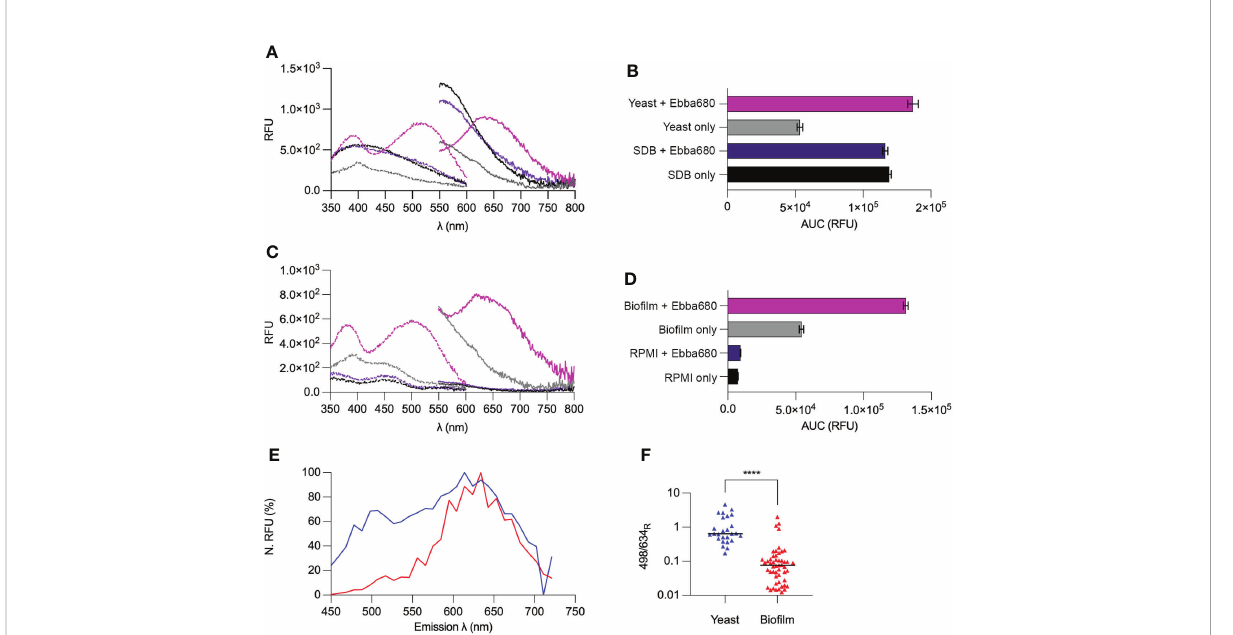
FIGURE 5 Optotracing yeast cells and bio fi lms. (A) Spec-plot of SDB (black), Ebba680 in SDB (purple), yeast cells (gray) and yeast cells in Ebba680 supplemented SDB (pink). (B) The total fl uorescence intensity, calculated as the area under the curve in the emission spectra (AUC) of SDB (black), Ebba680 in SDB (purple), yeast cells (gray) and yeast cells in Ebba680 supplemented SDB (pink). (C Spec-plot of RPMI (black), Ebba680 in RPMI (purple), bio fi lms (gray) and bio fi lms in Ebba680 supplemented RPMI (pink). (D) The total fl uorescence intensity, calculated as the area under the curve in the emission spectra (AUC) of RPMI (black), Ebba680 in RPMI (purple), bio fi lms (gray) and bio fi lms in Ebba680 supplemented RPMI (pink). All lines and bars show mean of n=3, with 3 technical repeats. In (C, D) , the standard deviation is shown. Dashed lines in spec-plots indicate the excitation spectra (dash), while solid lines indicate the emission spectra. (E) Spectral imaging analysis of intracellular amyloid bodies showing the emission spectra of regions of interest from intracellular amyloid aggregates from yeast (blue) and bio fi lms (red), shown in a Normalized Spec-plot. (F) Plot of the ratio of emission intensities at wavelengths of 498 and 634nm for Ebba680 following binding to intracellular amyloid aggregates in yeast (blue triangles) and bio fi lm (red triangles). The mean of all ROIs is shown. Data from three independent experiments are shown. **** denotes a P-value of <